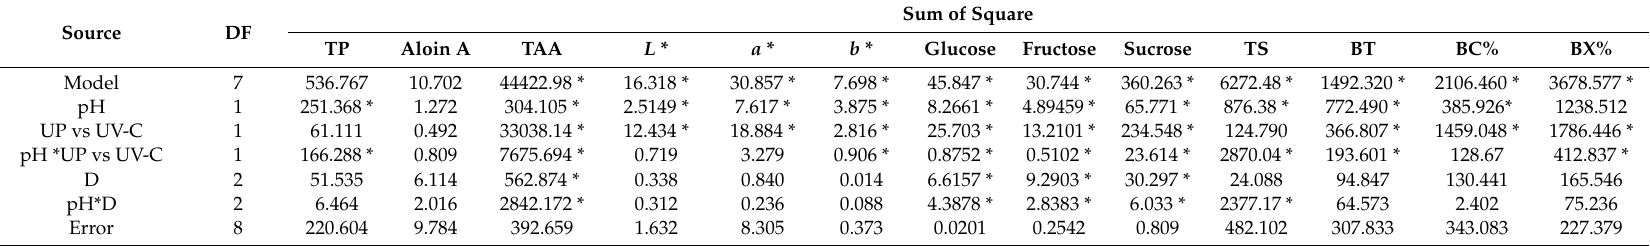
Table 1. Contrast analysis of treatment e ff ects on the physicochemical properties of Aloe vera –pitaya blends at di ff erent pH values. Source